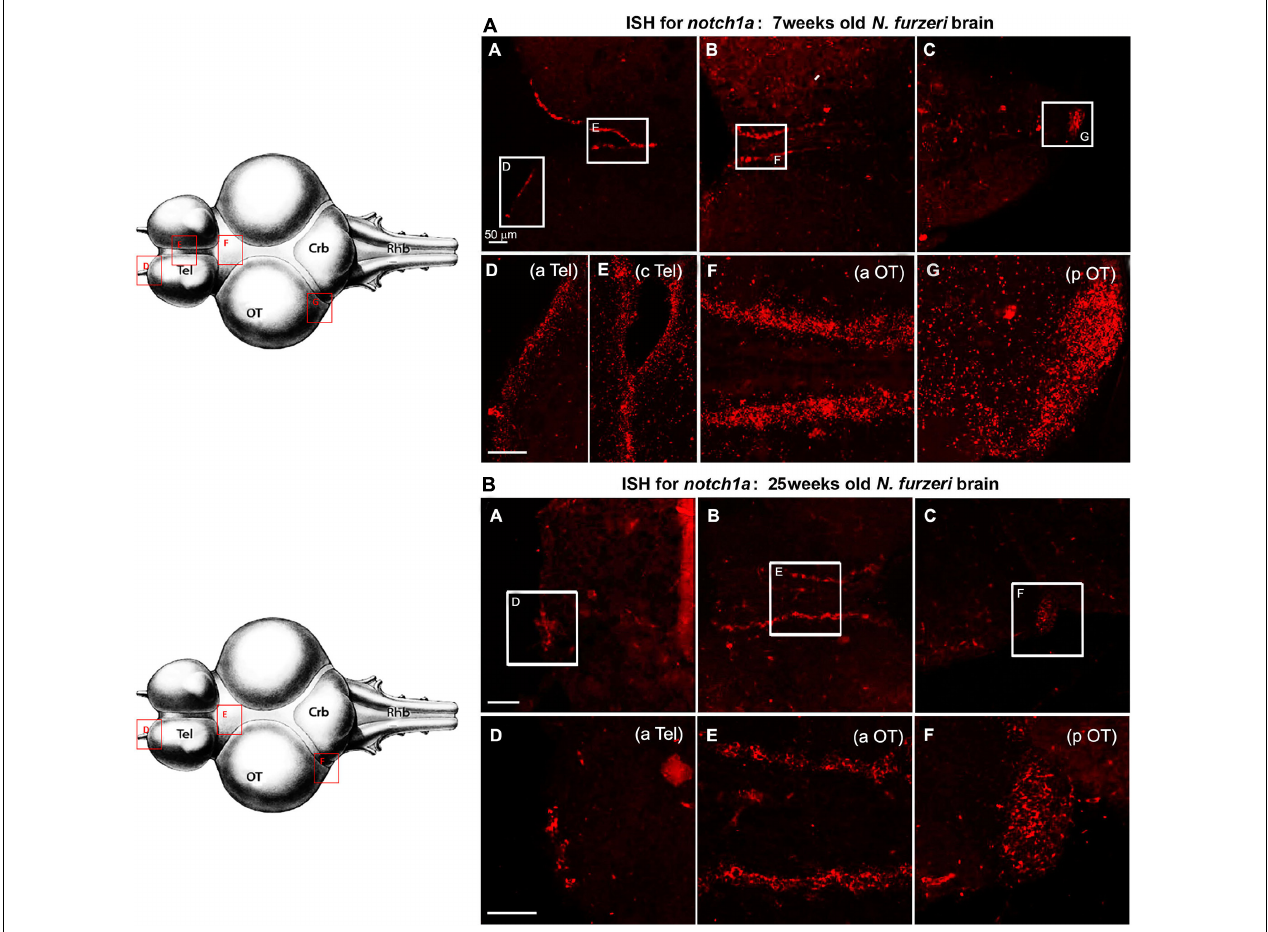
FIGURE 5 | Notch1 expression in proliferative niches of 7-weeks-old (A : A–G) vs. 25-weeks-old (B : A–F) N. furzeri brain. (A) (A–C) Overview of the brain in horizontal medial section (along the dorso/ventral axis) stained for notch1a , respectively, in telencephalon (A) , anterior optic tectum (aOT) (B), and posterior optic tectum (pOT) (C) regions of a young N. furzeri brain (7 weeks). White frames show the areas magnified in panels (D–G), representing, respectively, the anterior (aTel) and central (cTel) telencephalic regions and the anterior (aOT) and posterior optic tectum regions. (B) (A–C) Overview of the brain in horizontal medial section (along the dorso/ventral axis) stained for notch1a , respectively, in telencephalon (A) , anterior optic tectum (aOT) (B) and posterior optic tectum (pOT) (C) regions of an old N. furzeri brain (25 weeks). White frames show the areas magnified in panels (D–G), representing, respectively, the anterior (aTel) and central (cTel) telencephalic regions and the anterior (aOT) and posterior (pOT) optic tectum regions. Scale bars always represent 50 µ m and are indicative for all further images without specific scale bar indication. Brain drawing on the left (modified from D’angelo, 2013–Atlas) represents the horizontal overview of the whole killifish brain; red-squared areas indicate the position of the figure panels based on the corresponding